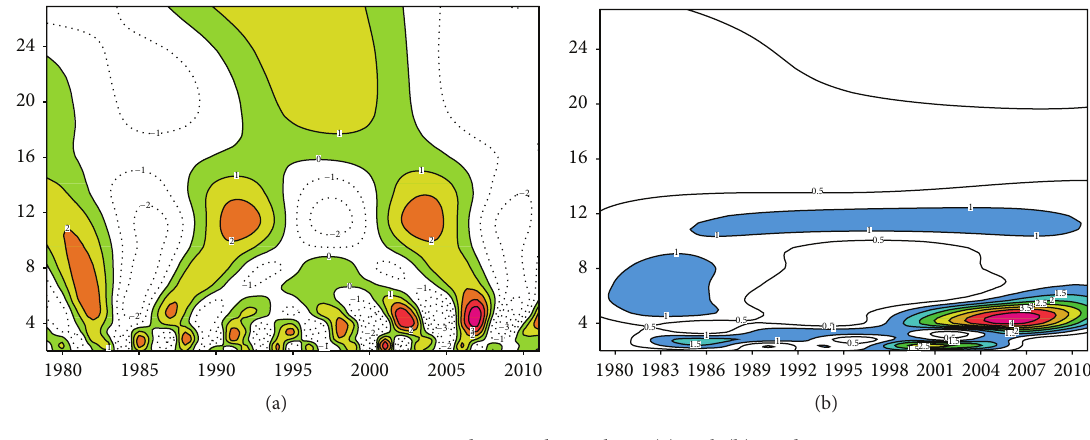
Figure 4: AWH index wavelet analysis: (a) real; (b) mode.